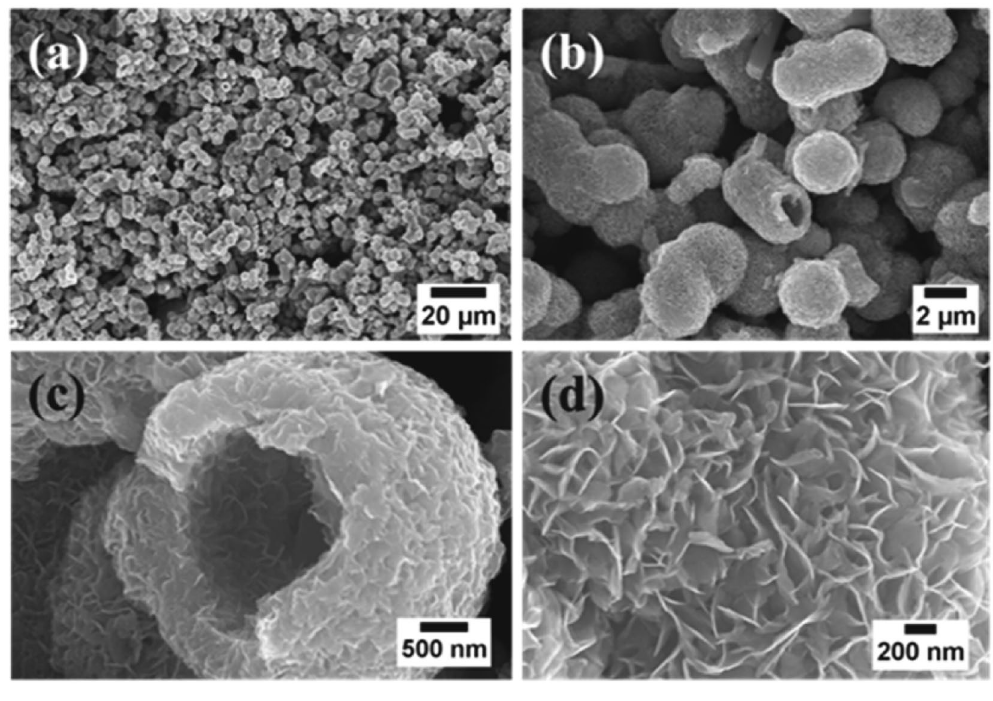
Figure 2. SEM image of MoS 2